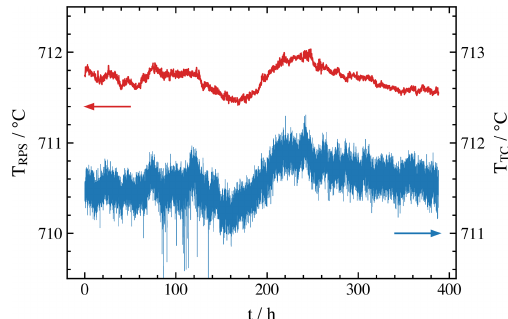
Figure 14. Temperature obtained by means of the resonance piezo- electric spectroscopy, T RPS , using housed resonator and tempera- ture obtained from a type S thermocouple, T TC . The temperature scales are shifted by 1K for